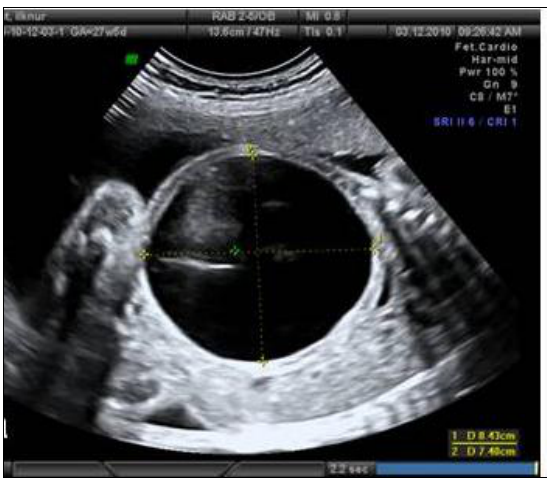
Figure 1: A huge cyst in fetus compressing surrounding structures Umbilical artery Doppler velocity indices were normal. There was no sign of fetal hydrops. The Figure 2: Newborn with catheter